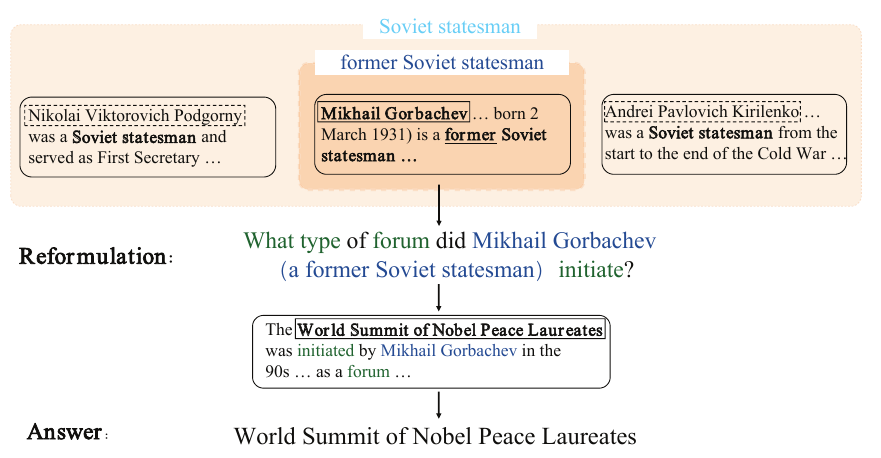
Figure 1. Examples of challenges in HotpotQA